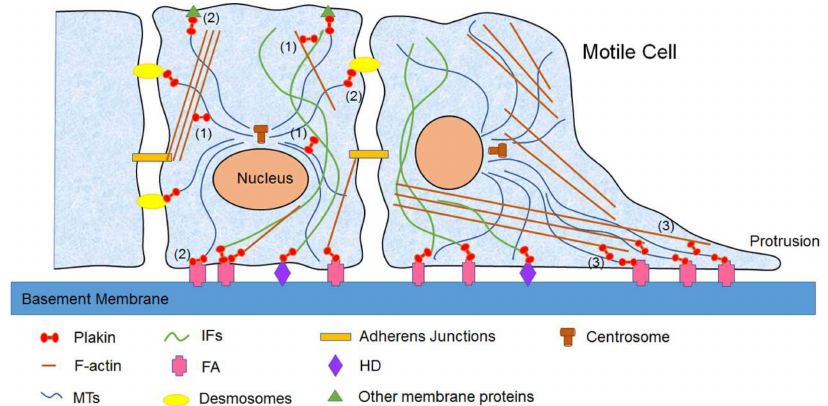
Figure 2. Schematic illustration of the regulatory role of mammalian plakins in cell migration and cytoskeletal dynamics. Plakins regulate cytoskeletal dynamics and cell migration by crosslinking different cytoskeletal networks and adhesion complexes. As giant cytolinkers, plakins show key roles in at least three different cellular processes, as indicated in this figure. ( 1 ) Plakins crosslink all three cytoskeletal elements: F-actin, MTs, and IFs; ( 2 ) Plakins connect the cytoskeleton with adherens junctions or membrane proteins; ( 3 ) Plakins guide MTs along F-actin to target FAs to regulate cell